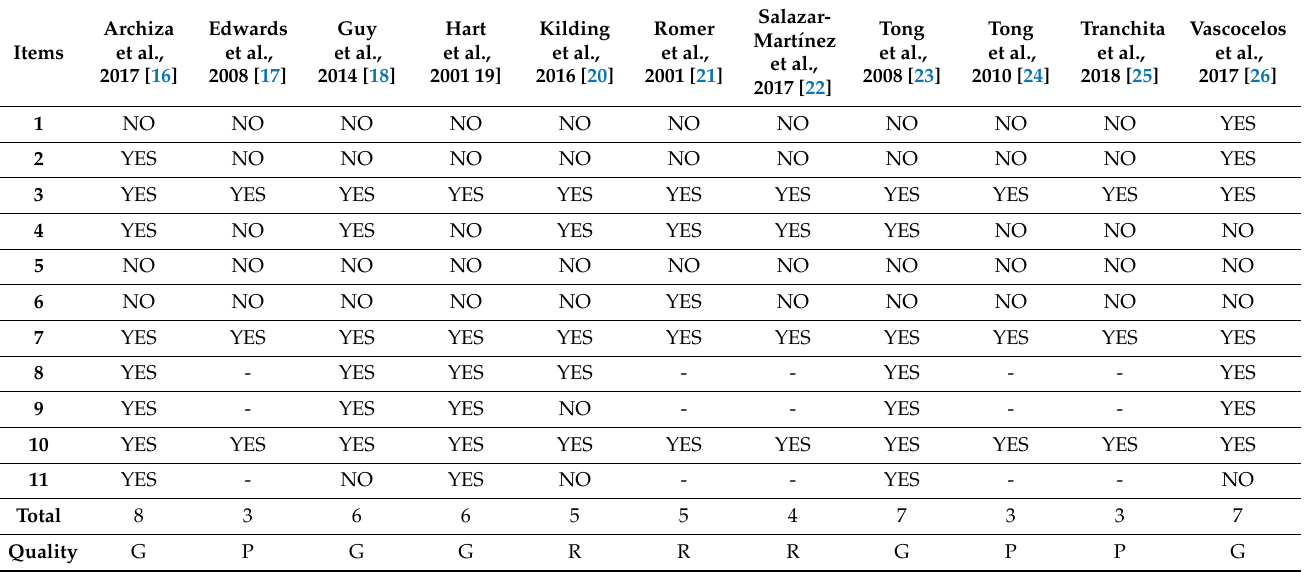
Table 5. Cochrane’s assessment of quality [10].